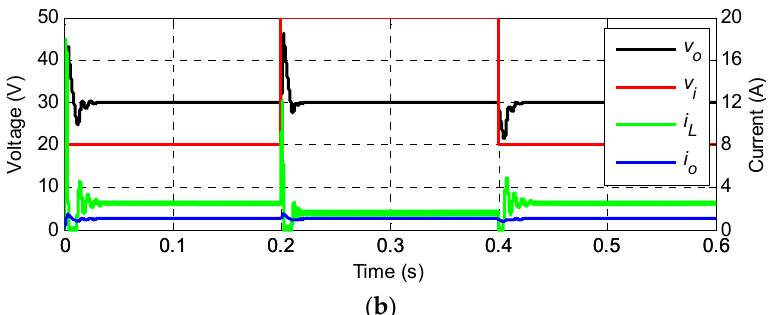
Figure 9. Waveforms of voltage and current of a buck–boost converter with a pure resistive load under power supply disturbances: ( a ) inverse-system decoupling controller; ( b ) conventional double closed-loop controller.